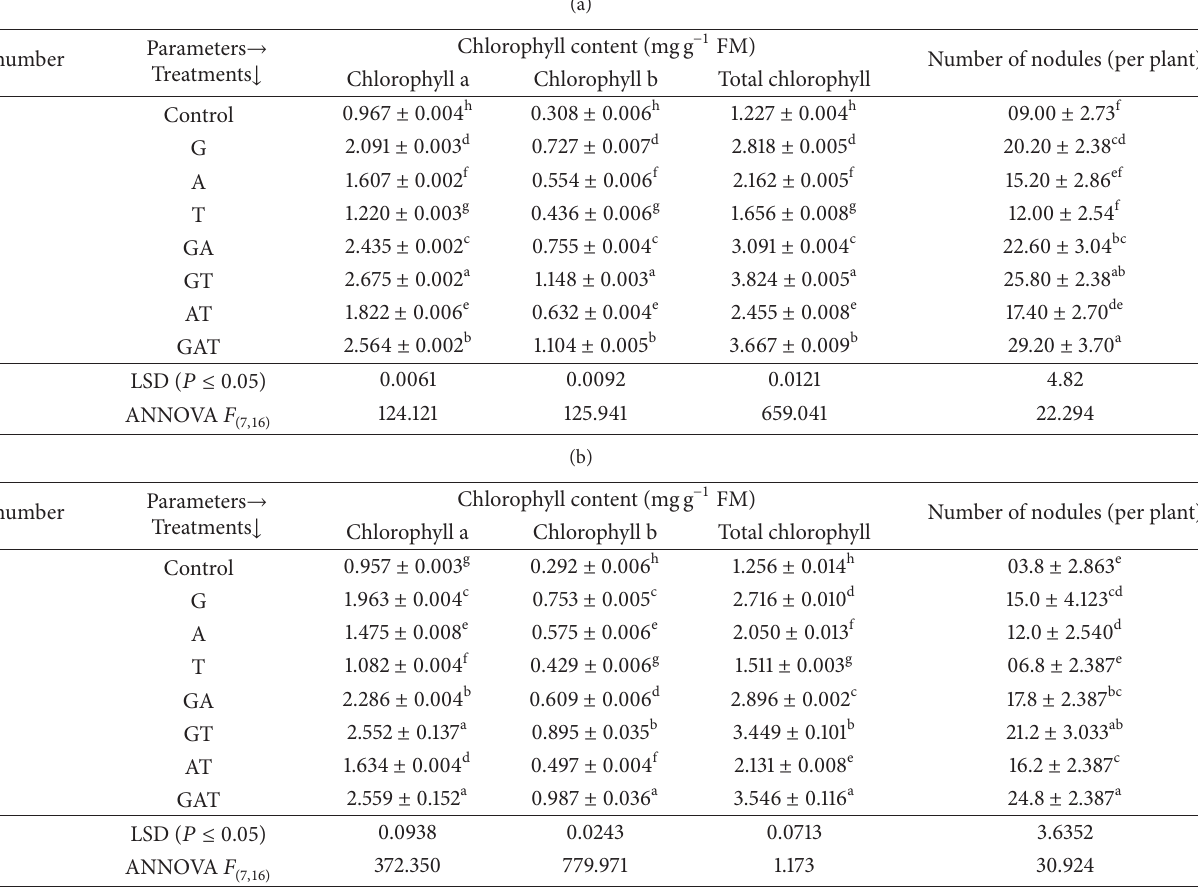
Table 1: (a) Interactive effect of AM fungi and T. viride on chlorophyll content and nodulation of Phaseolus mungo var. UH-1 after 120 days of inoculation. (b) Interactive effect of AM fungi and T. viride on chlorophyll content and nodulation of Phaseolus mungo var. IPU-94-1 after 120 days of